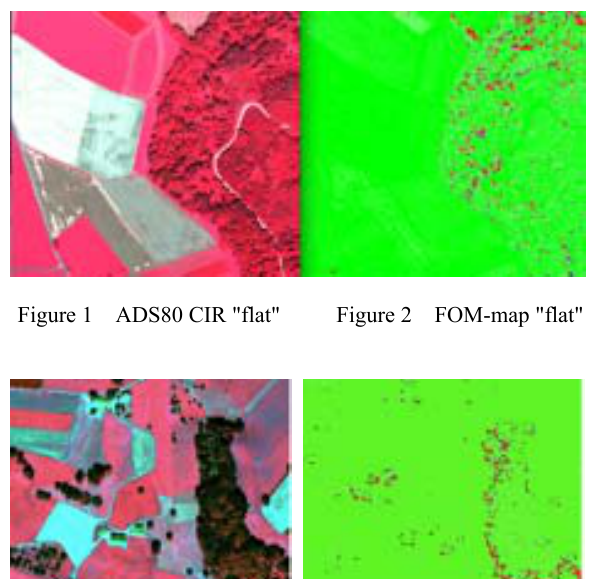
Table 1 . Percentage of LiDAR-DSM and -DTM points